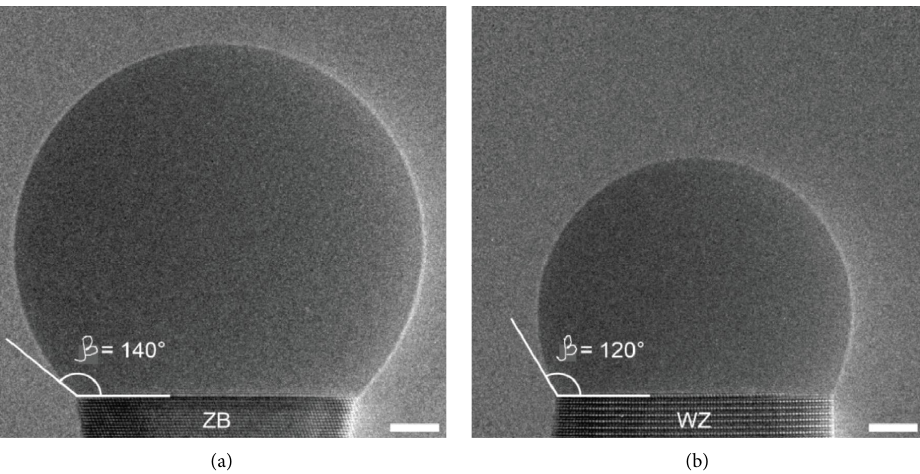
Figure 1: Images of vertices of NWs GaAs structures zincblende (ZB) (a) and wurtzite (WZ) (b). Catalyst—Ga